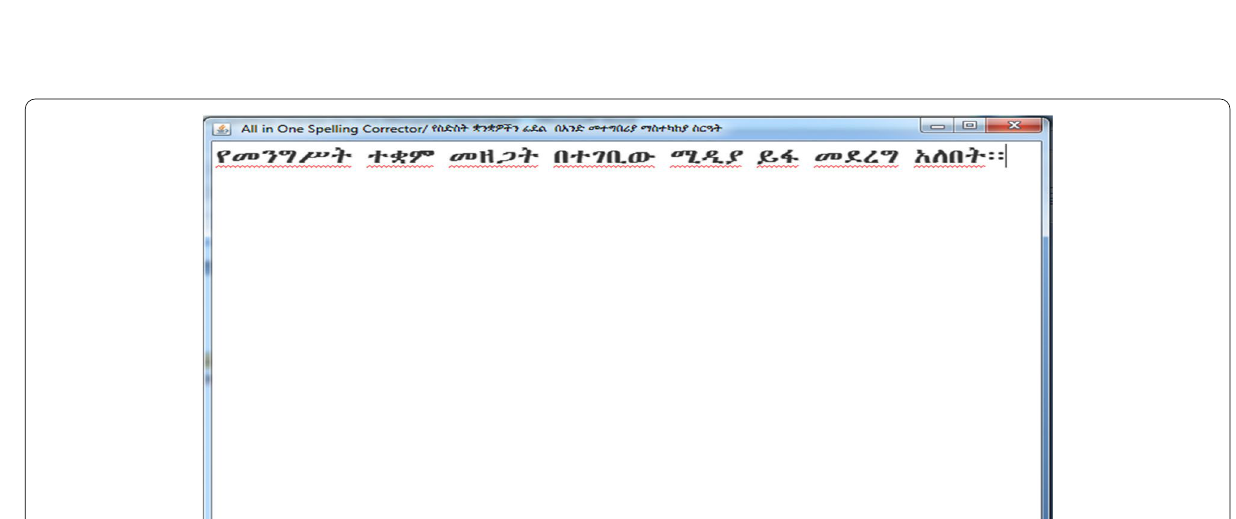
Fig. 4 List of words that are not in Amharic dictionary